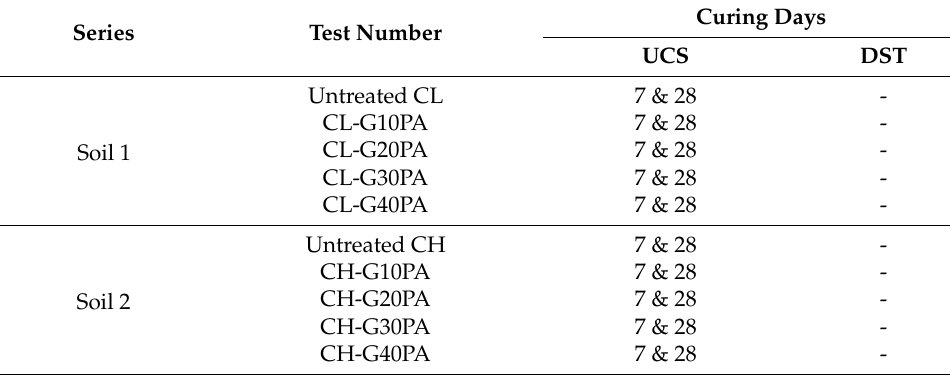
Table 3. Mixing proportions of different tests.